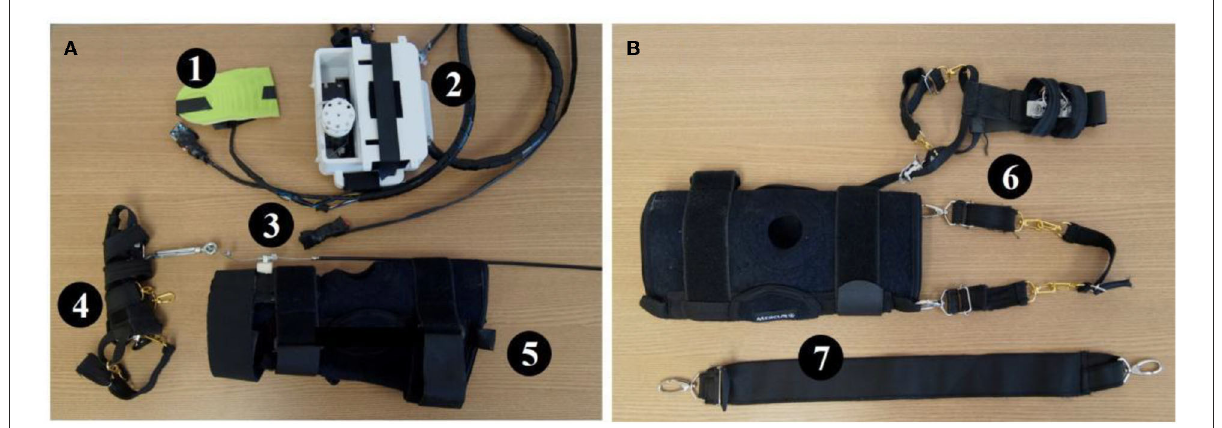
FIGURE3 (A) Active system: (1) Insole with pressure sensor and sensor inertial. (2) Case to hold the servo motor, voltage regulator, battery, and microcontroller. (3) Emergency button. (4) Adapted firm foot strap. (5) Articulated knee brace with mechanism to hold a Bowden cable end